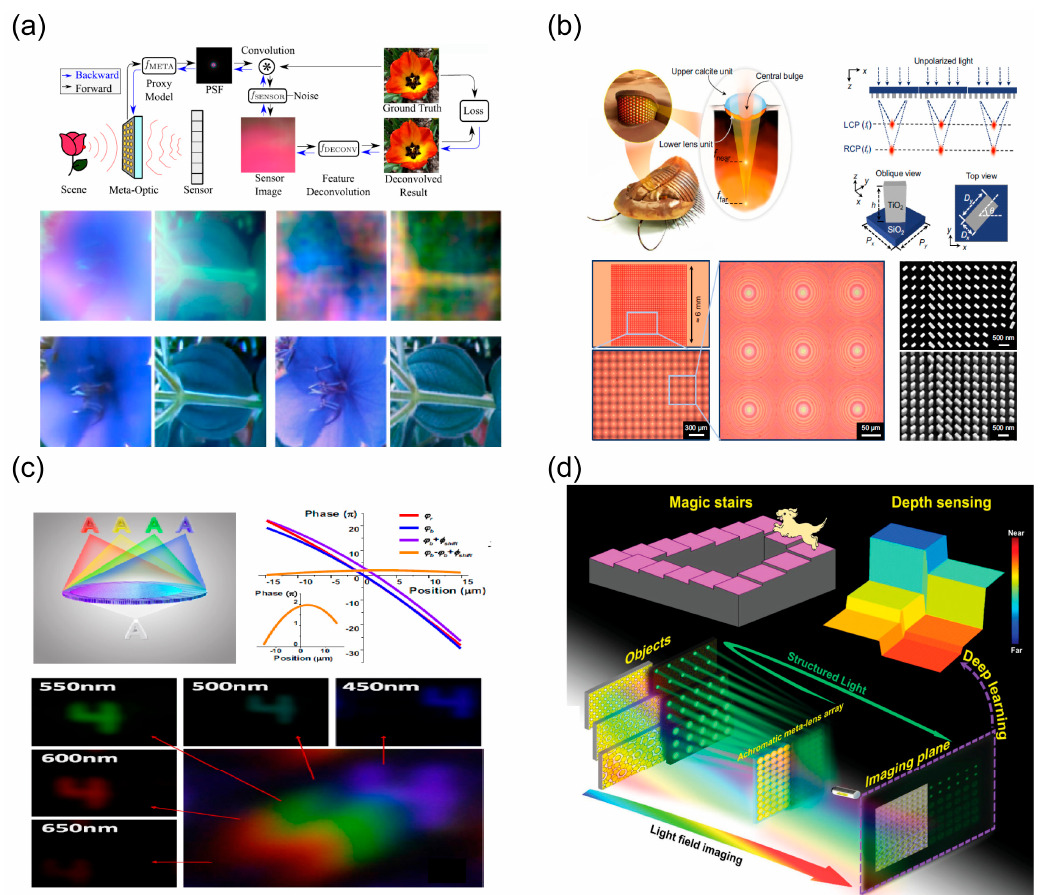
Figure 8. Metalens-based computational imaging. ( a ) Computational imaging using an optimized phase pro fi le metalens and the deep learning reconstruction algorithm has enabled the reduction in monochromatic and chromatic aberrations [150]. ( b ) A nano-photonic light- fi eld camera inspired by Trilobite that uses a spin-multiplexed bi-focal metalens array to deeply increase the depth of fi eld [199]. ( c ) Spectral light- fi eld imaging achieved by using a transversely dispersive metalens [200]. ( d ) Schematic of an achromatic metalens array’s depth-sensing system [201].